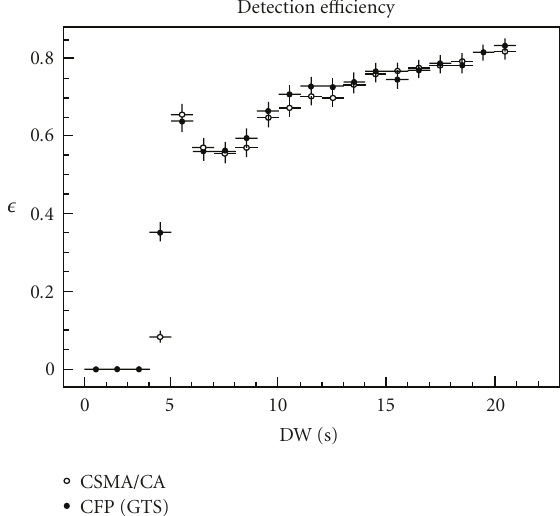
Figure 30: E ffi ciency behavior as a function of the DW width for the case of CSMA/CA (empty markers) and the GTS (filled